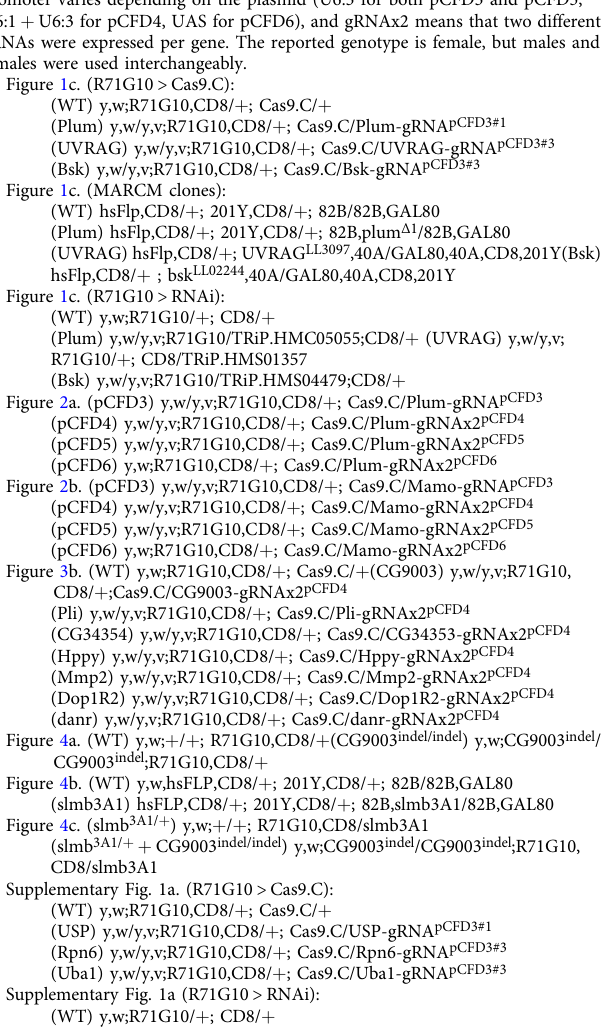
Figure 4a. (WT) y,w; + / + ; R71G10,CD8/ + (CG9003 indel/indel ) y,w;CG9003 indel / CG9003 indel ;R71G10,CD8/ + Figure 4b. (WT) y,w,hsFLP,CD8/ + ; 201Y,CD8/ + ; 82B/82B,GAL80 (slmb3A1) hsFLP,CD8/ + ; 201Y,CD8/ + ; 82B,slmb3A1/82B,GAL80 Figure 4c. (slmb 3A1/ + ) y,w; + / + ; R71G10,CD8/slmb3A1 (slmb 3A1/ + + CG9003 indel/indel ) y,w;CG9003 indel /CG9003 indel ;R71G10, CD8/slmb3A1 Supplementary Fig. 1a. (R71G10> Cas9.C): (WT) y,w;R71G10,CD8/ + ; Cas9.C/ +